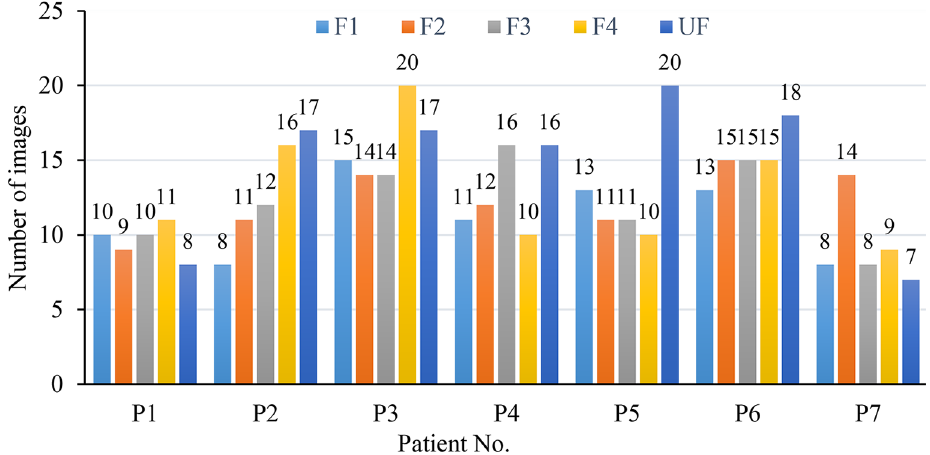
Fig 8. Distribution of the number of images in five fractions corresponding to seven different